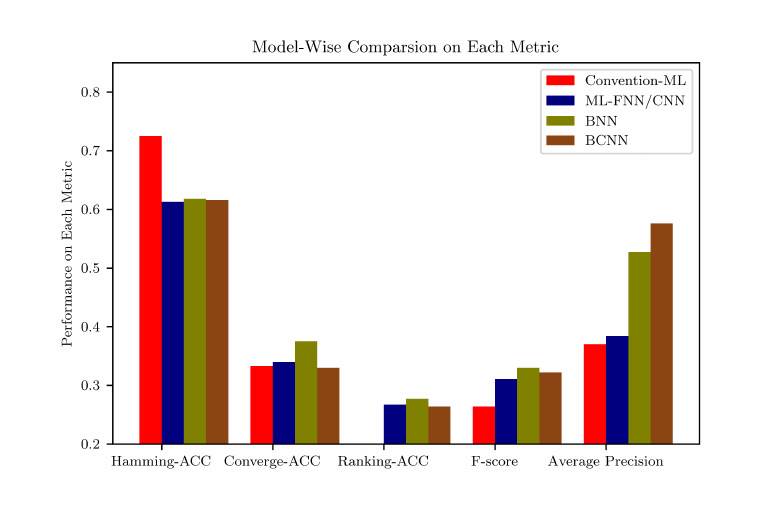
Figure 5. Model Wise Comparison on Multi-learning Metrics. Note here, for illustrative purposes, we used Hamming-ACC, Converge-ACC and Ranking-ACC instead of original loss based metrics. Rather than the averaging over the models in each category, e.g., Conventional-ML, we picked the most representative model in each category for different